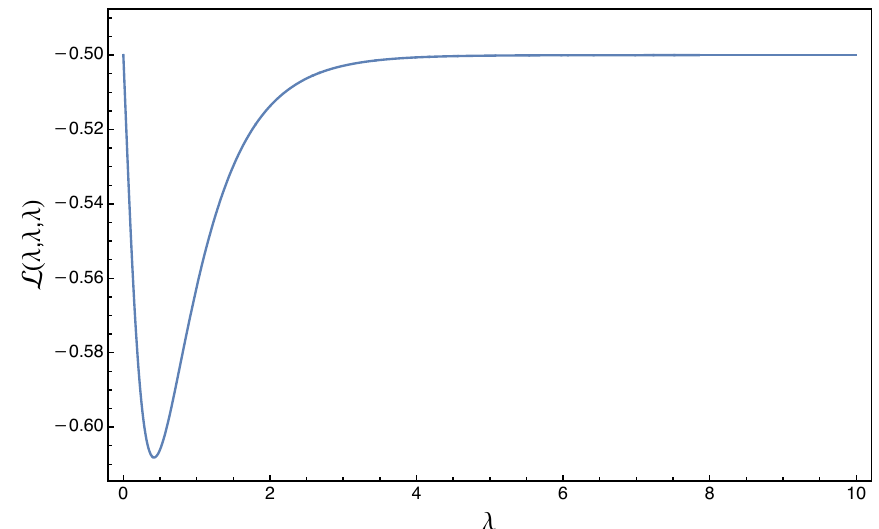
Figure 5 . The plot of L ( λ, λ, λ ) as a function of λ . Note that the floor of this function gives − 1 in the range shown. An analytic proof for ˜ l 1 = − 1 for any λ > 0 would require better understanding of L ( λ, λ, λ ) , especially for the large values of λ